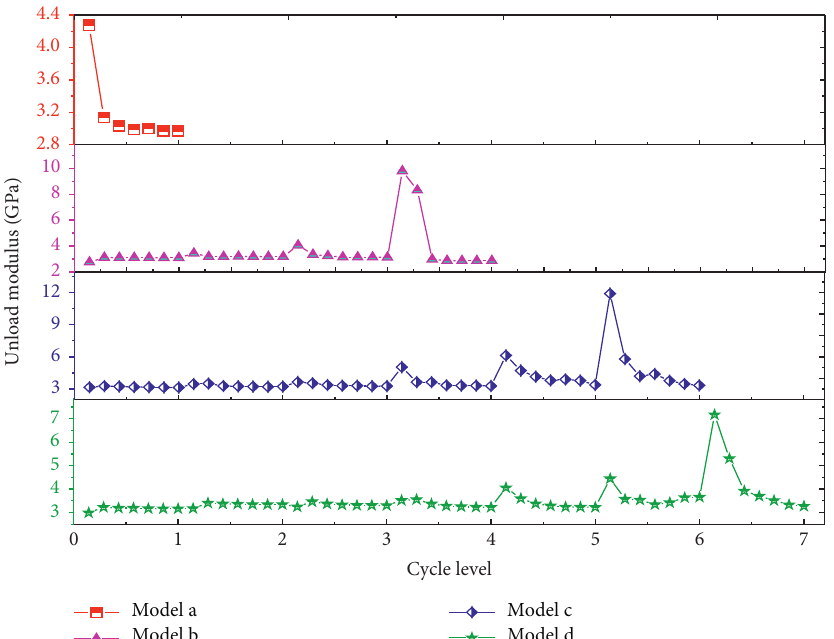
Figure 19: Unload response (E – ) of coal sample with different particle